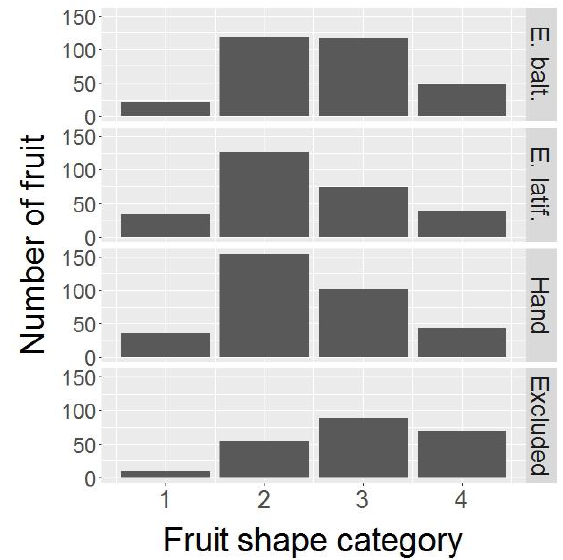
F IGURE 5. Fruit shape category frequency distributions by pollination treatment (1 = highly symmetrical fruit with no malformations; 2 = slightly asymmetrical fruit with minimal malformations; 3 = fruit with clear asymmetry and/or some malformations; 4 = fruit with major malformations). Fruit that fell into category 3 or 4 were deemed unmarketable. “E. balt.” is